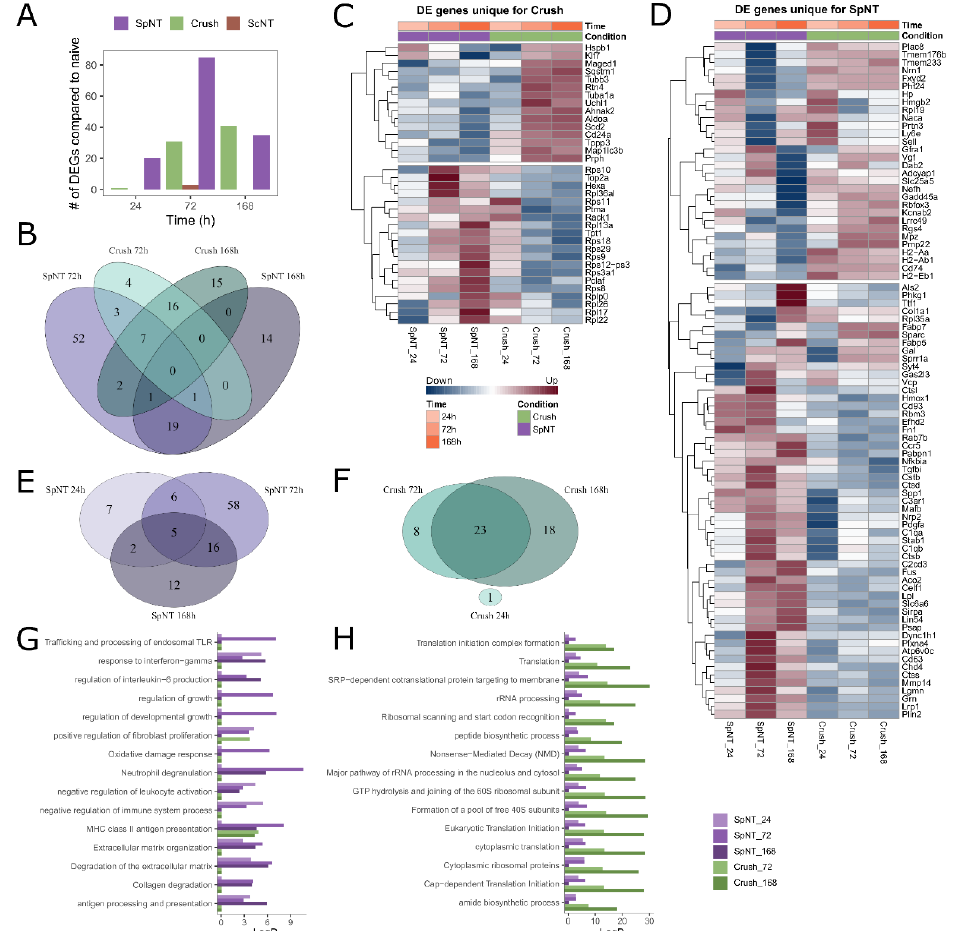
Figure 3. Spinal nerve transection modulates inflammatory responses of macrophages, while sciatic nerve crush affects translational capacity of macrophages. ( A ) The number of statistically significant DEGs in macrophages after different PNI models. ( B ) The number of overlapping and unique DEGs at 72 h and 168 h time points after the SpNT or Crush. ( C ) Scaled log2 fold change to naïve shown for the DEGs which were statistically significant only in the Crush model (time points 72 h and 168 h compared to the same time points of the SpNT as in ( B )). ( D ) Scaled log2 fold change to naïve shown for the DEGs which were statistically significant only in the SpNT model. ( E ) and ( F ) Number of overlapping and unique DEGs at different time points in SpNT or Crush, respectively. ( G ) Fifteen most enriched pathways in the SpNT groups and their LogP values were determined using Metascape pathway analysis tool. ( H ) Fifteen most enriched pathways in the Crush groups. Abbreviations: spinal nerve transection (SpNT); sciatic nerve crush (Crush); sciatic nerve transection (ScNT); differentially expressed (DE); DE gene (DEG).